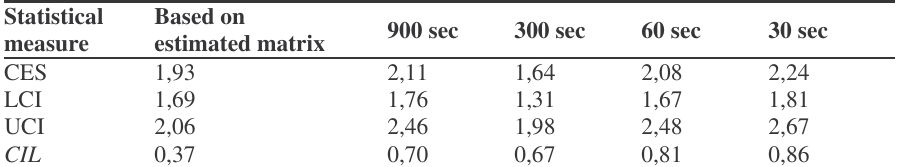
Table 1. Estimated values of CES , LCI , UCI and CIL